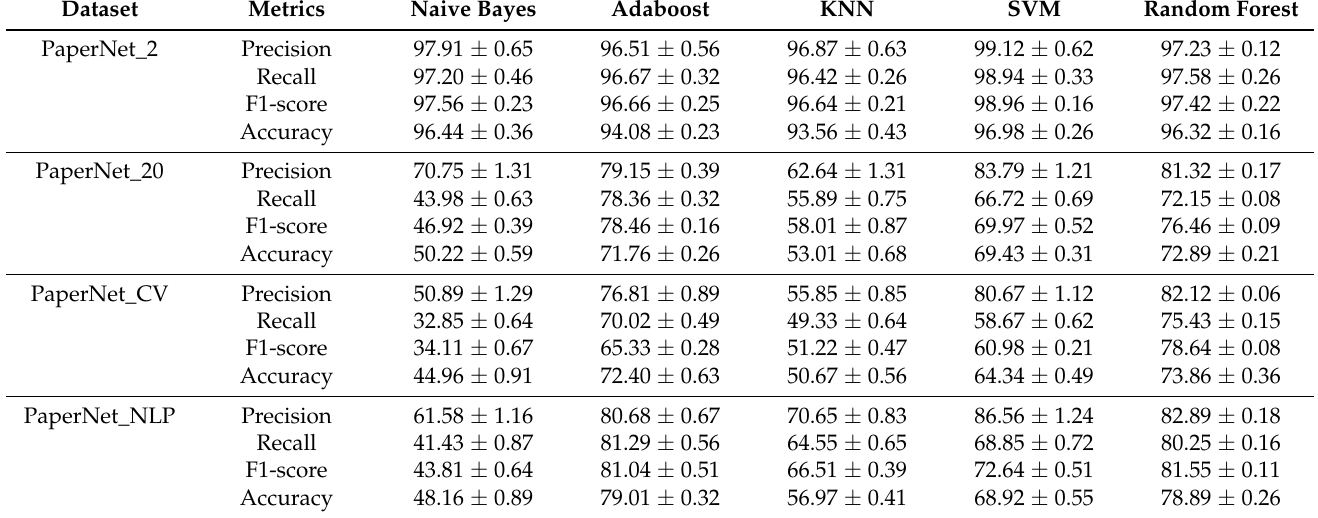
Table 4. Performance comparison of machine learning